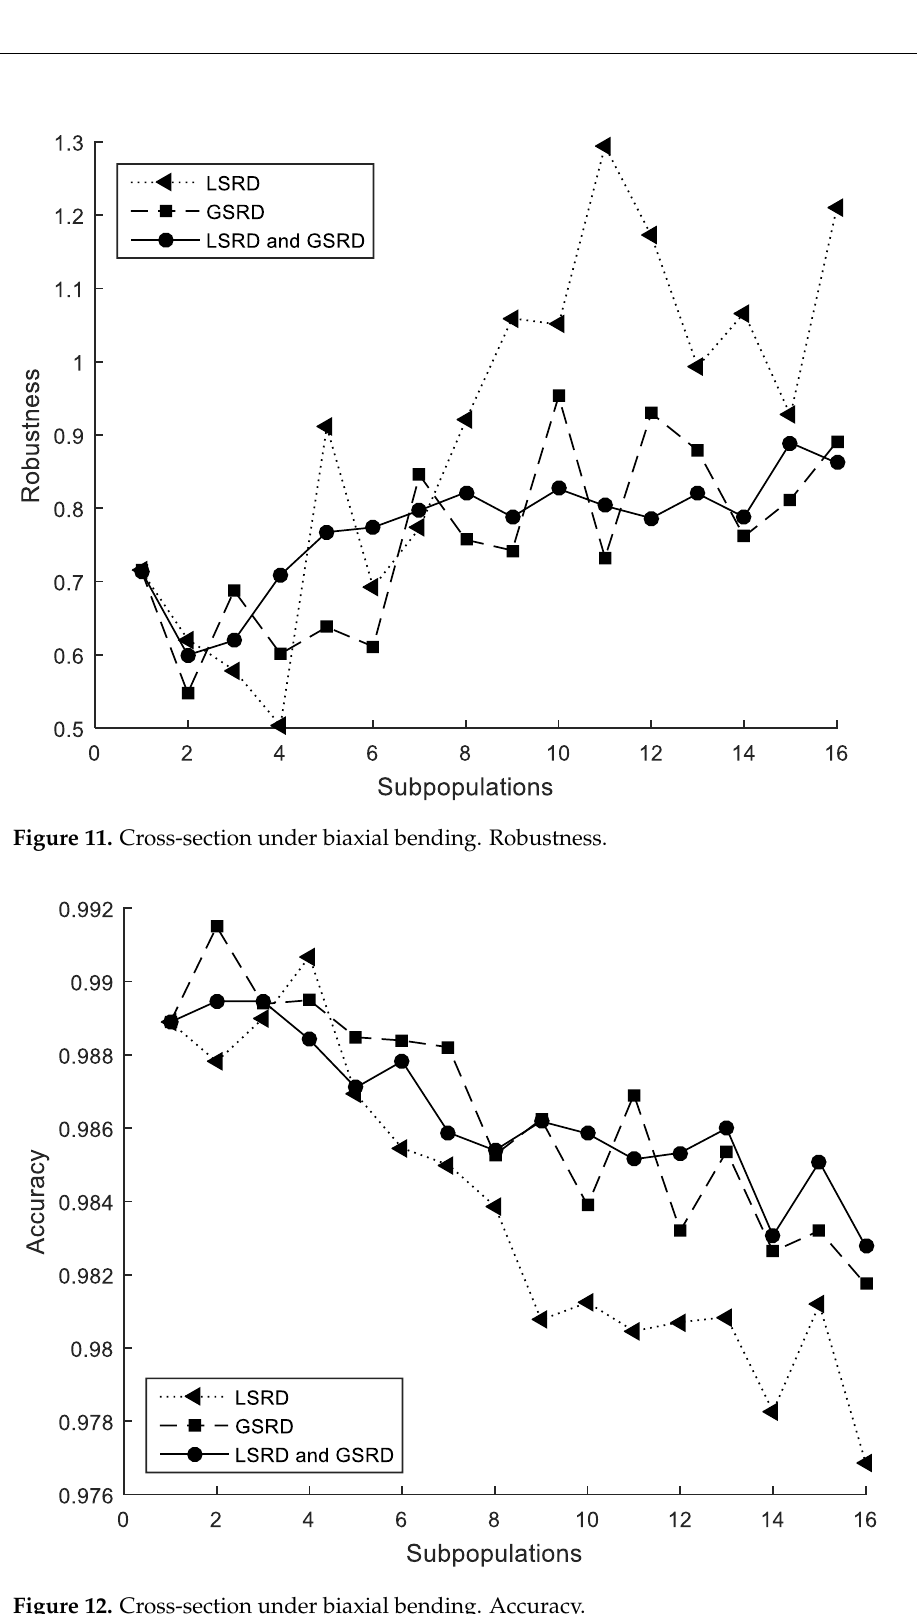
Figure 10. Cross-section under biaxial bending. Mean cost.